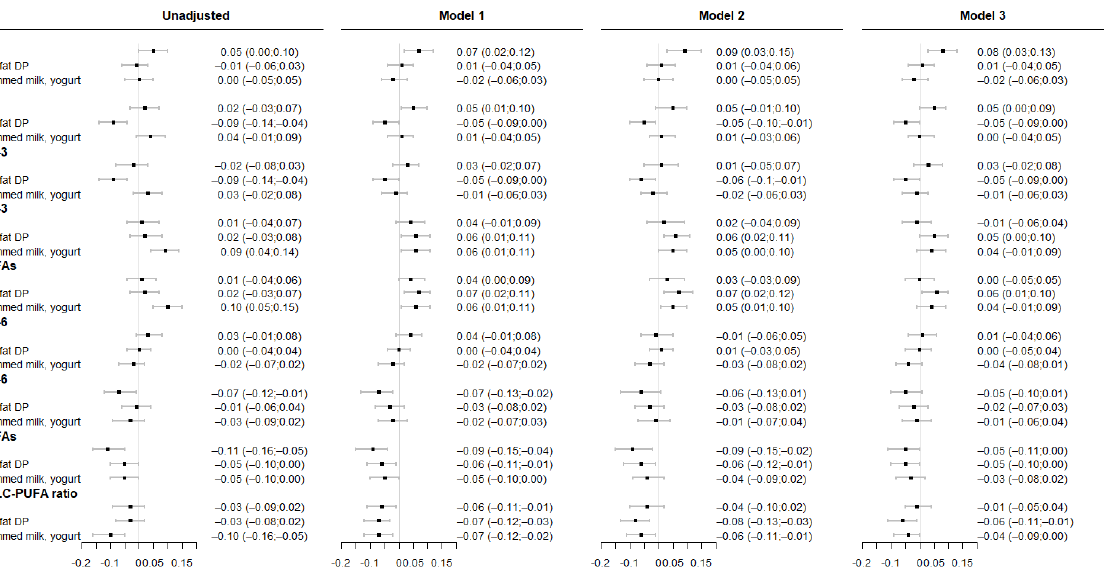
Associations between maternal DP patterns and fatty acids composition in colostrum are presented in Figure 4. Greater adherence to the “cheese” pattern was associated with higher C15:0 level and lower LA, total n-6 PUFA across all models. Higher adherence to “reduced-fat DP” pattern was only associated with lower C15:0 level. Finally, greater adherence to “semi-skimmed milk, yogurt” pattern was associated with higher C15:0, C17:0 levels and with lower total n-6 PUFA and n-6/n-3 LC-PUFA ratio; however, associations with the total n-6 PUFA level and the ratio were not significant after accounting for either maternal healthy dietary pattern or fish consumption during preg- nancy. No association was observed with AA and n-3 PUFAs (ALA, DHA).